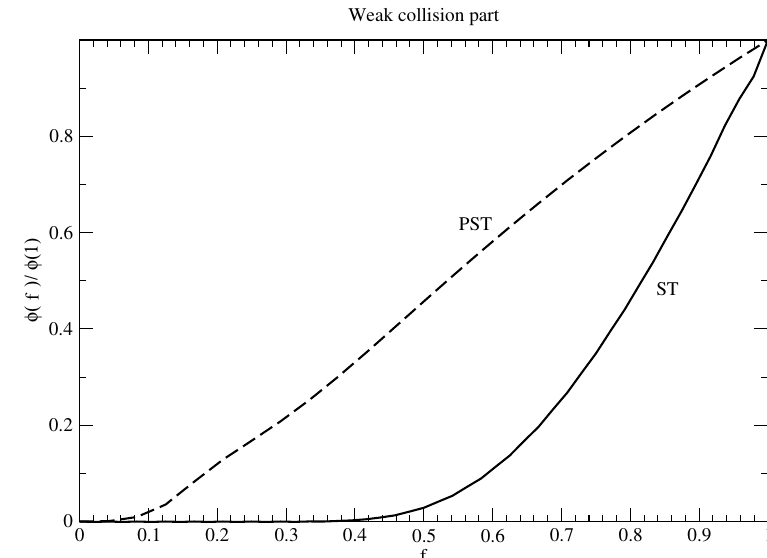
Figure 5. Illustration of Lewis cutoff interpolation table for both ST (solid) and a single PST “channel”